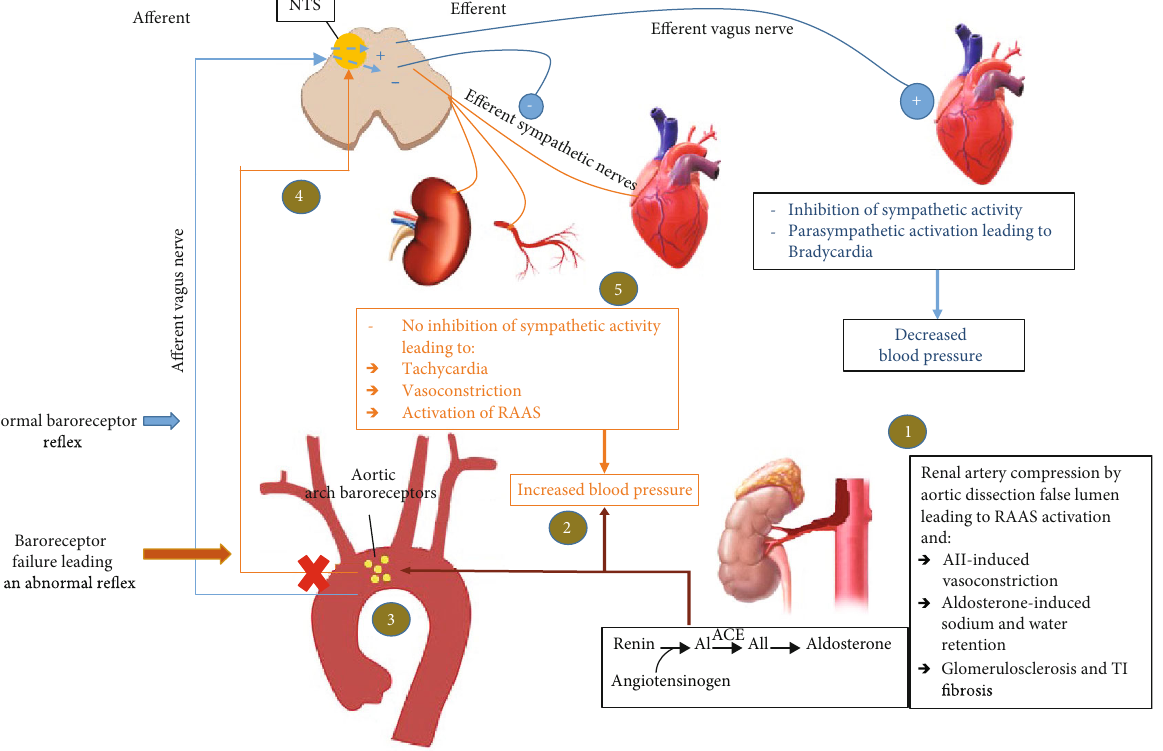
Figure 3: Schema representing the exaggeration in arterial BP in the setting of RVH and aortic arch baroreceptor failure. The rise in BP resulting from RVH (steps 1 and 2) is not transmitted to the NTS from aortic baroreceptors (steps 3 and 4). This results in the maintenance of e ff erent sympathetic out fl ow to the heart, kidneys, and blood vessels leading to further rise in blood pressure (step 5). Blue color: body response to elevated blood pressure via normal aortic arch receptors. Orange color: body response to hypertension in the setting of interrupted aortic arch receptors. BP: blood pressure; RVH: renovascular hypertension; NTS: nucleus tractus solitarius; AI: angiotensin I; AII: angiotensin II; ACE: angiotensin converting enzyme; RAAS: renin-angiotensin-aldosterone